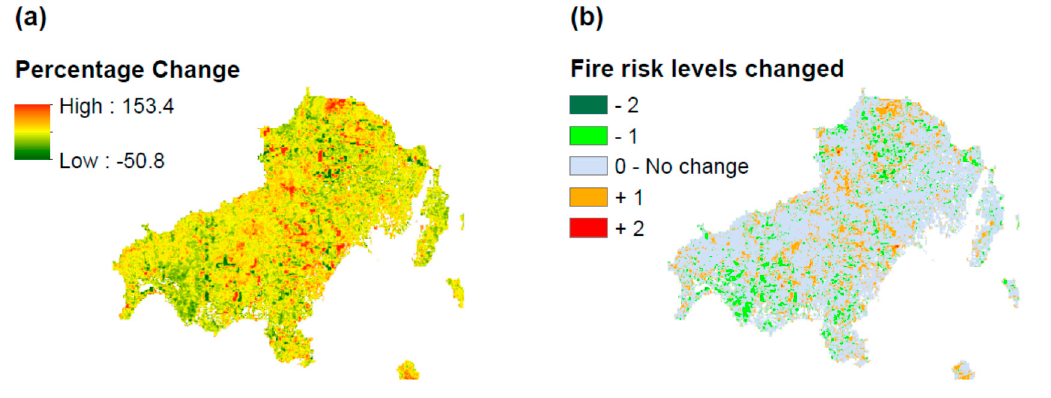
Figure 4. ( a ) Spatiotemporal percentage change of fire hazard, and ( b ) fire hazard levels changed (transition) from 1996 to 2016.